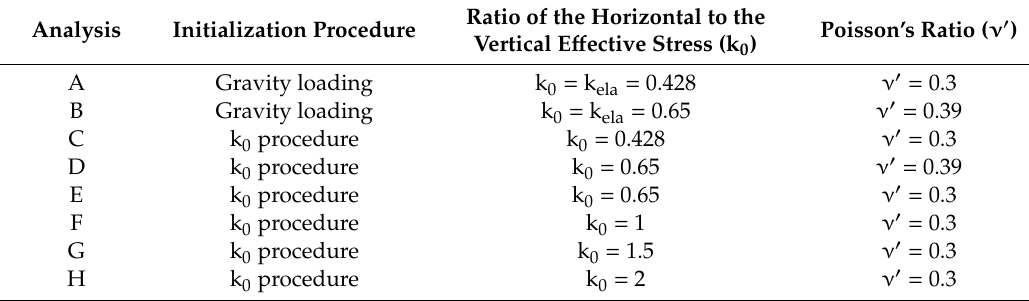
Table 2. Initialization stages of the numerical analyses discussed in the